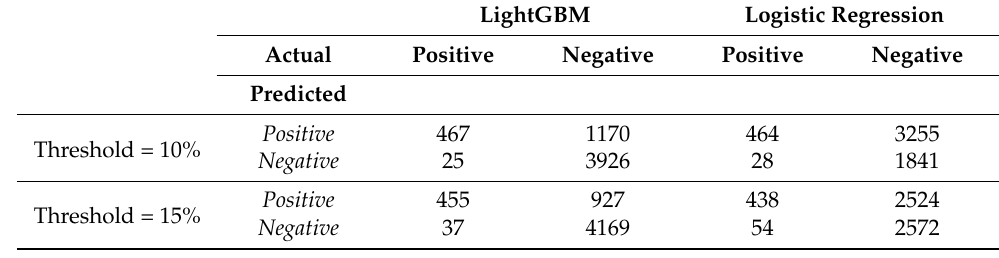
Table 3. Confusion matrix for different thresholds for the LightGBM and Logistic Regression models.